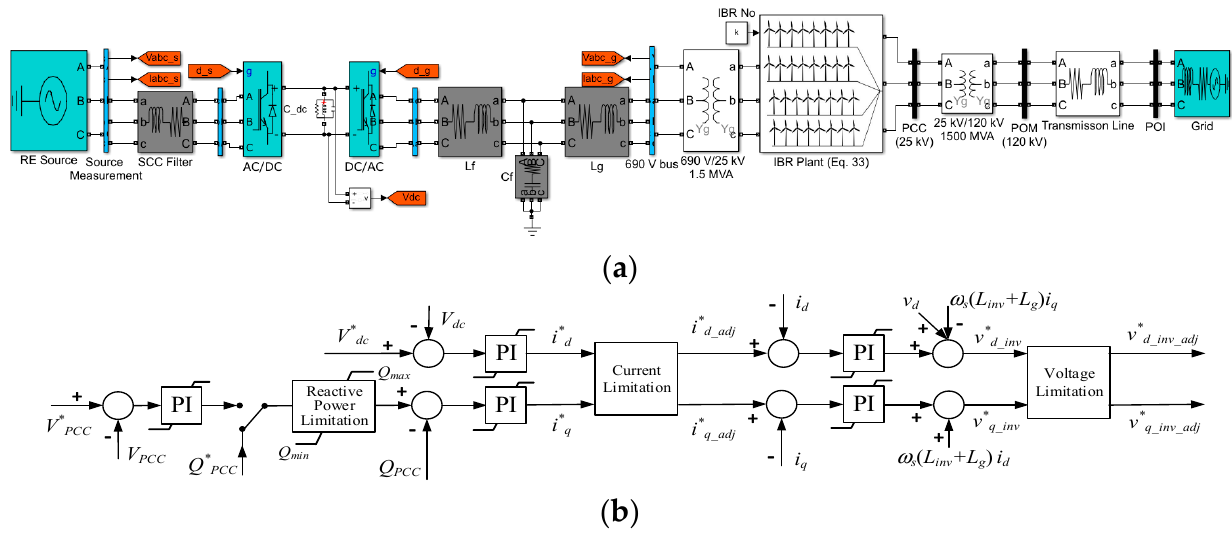
Figure 10. Con fi guration of the aggregated IBR plant model: (a) IBR plant structure, (b) IBR control Figure 10. Configuration of the aggregated IBR plant model: ( a ) IBR plant structure, ( b ) IBR con- structure. trol